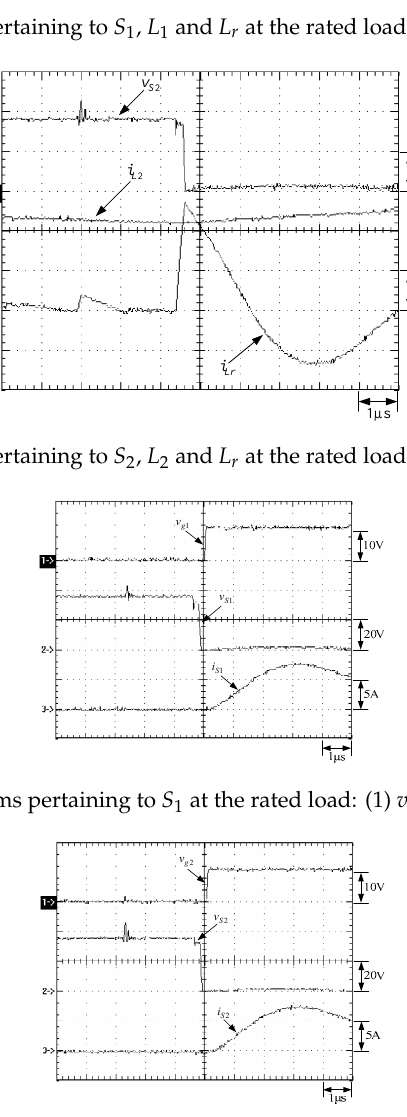
Figure 31. Waveforms pertaining to S 2 at the rated load: (1) v g 2 ; (2) v S 2 ; the (3) i S 2 .